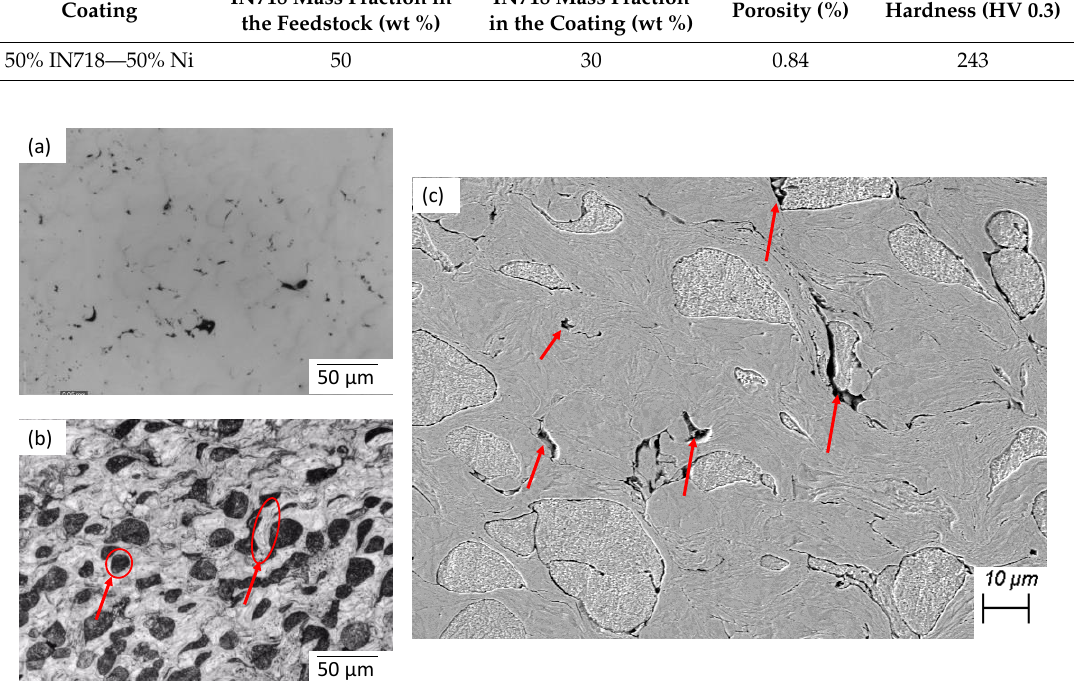
Figure 3. Cross-sectional images of the cold spray 50% IN718 – 50% Ni coating: ( a ) OM image; ( b ) OM image after etching; ( c ) SEM image.